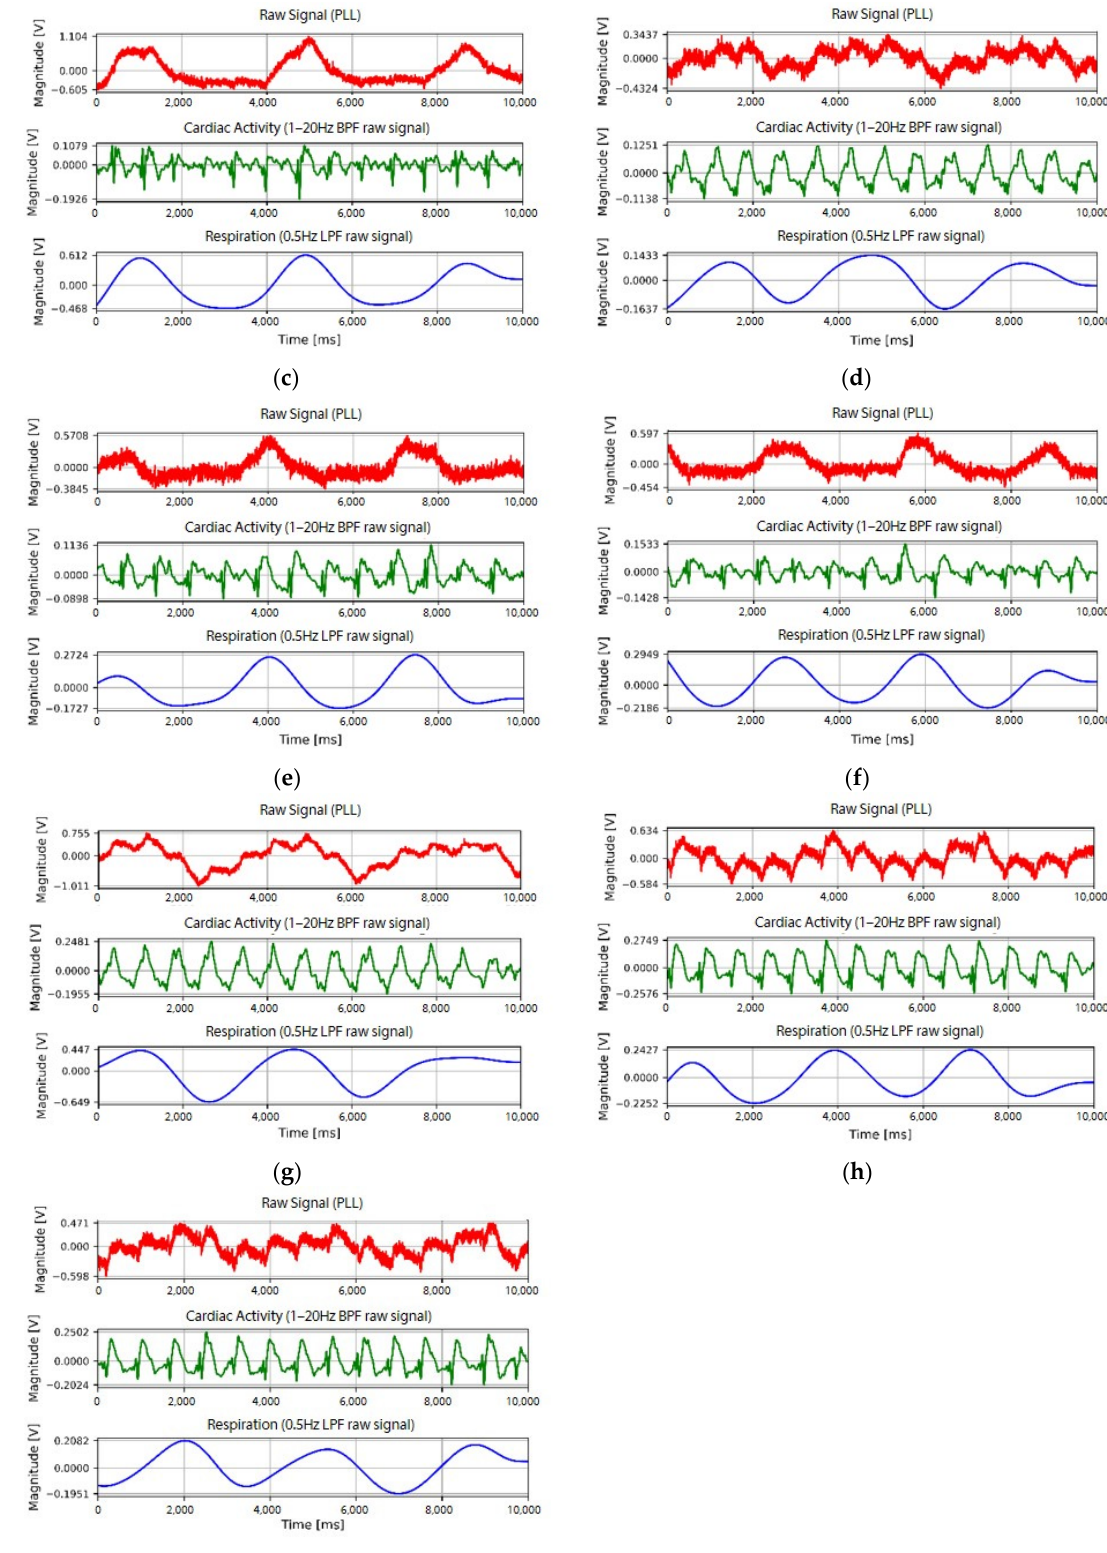
Figure 10. Cardiac activity and respiratory signals detected in subject A: spiky loop sensor at ( a ) P2,